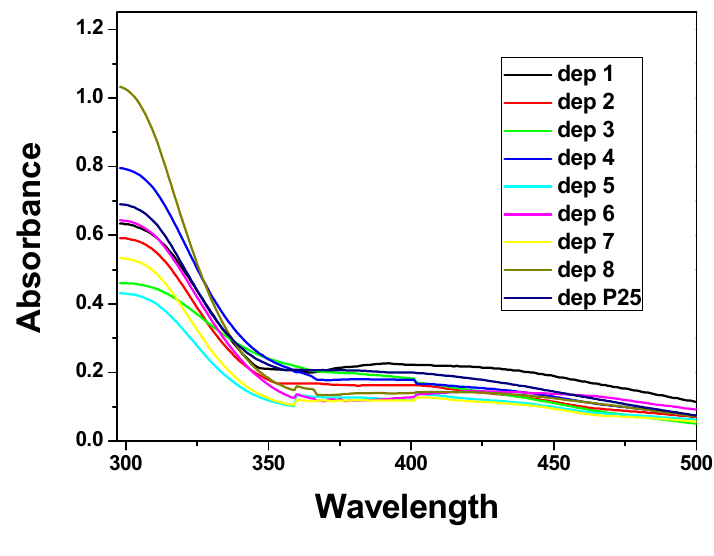
Figure 11. UV-Vis spectra (electronic spectra in the ultraviolet and visible region) of samples 1–8 and